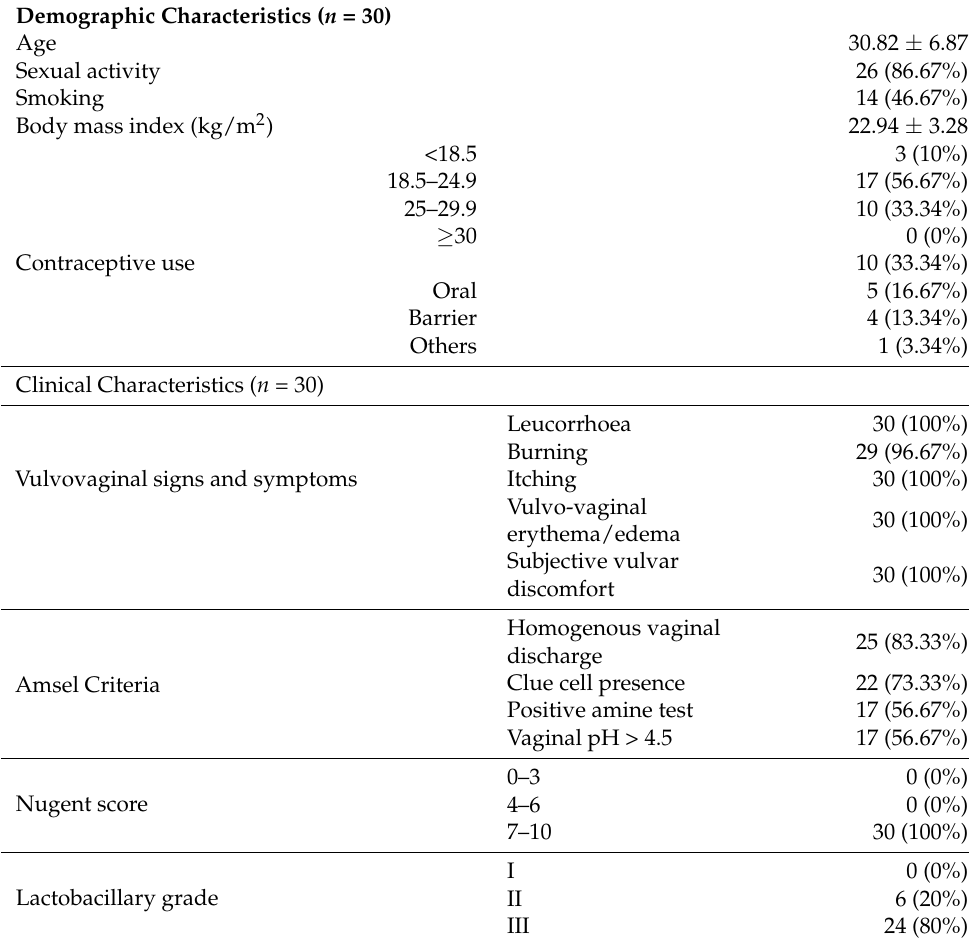
Table 1. Baseline demographics and clinical characteristics of the enrolled patients ( n =